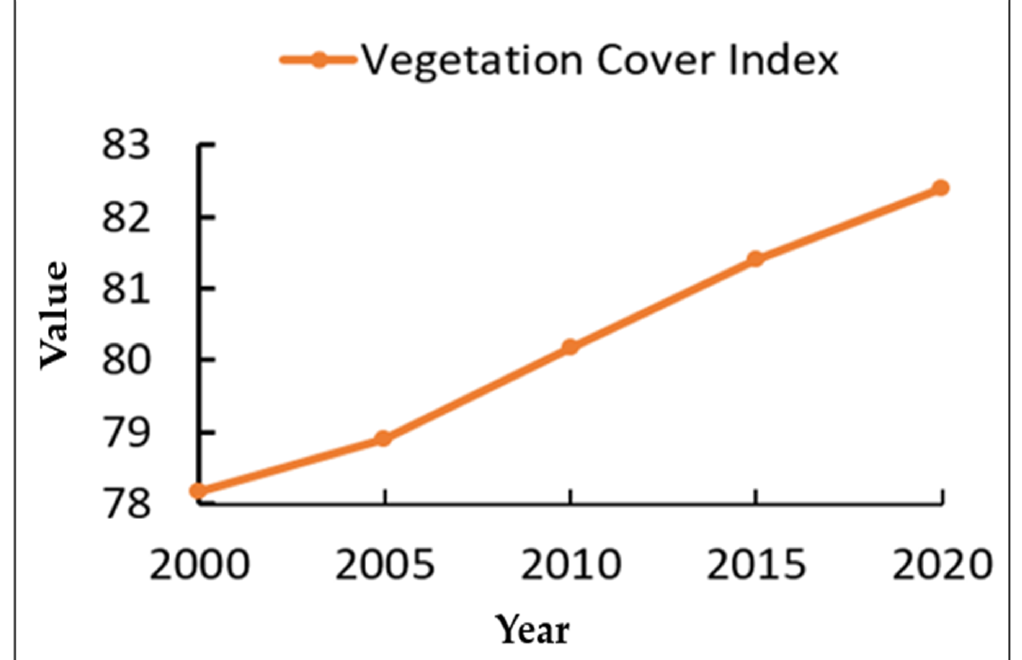
Figure 9. The change of vegetation cover index in Rangtang County.